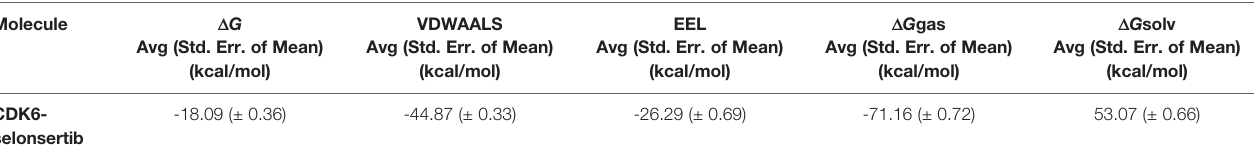
TABLE 2 | Binding free energy and interacting amino acid residues in the docked CDK6 and selonsertib complex. Molecule D